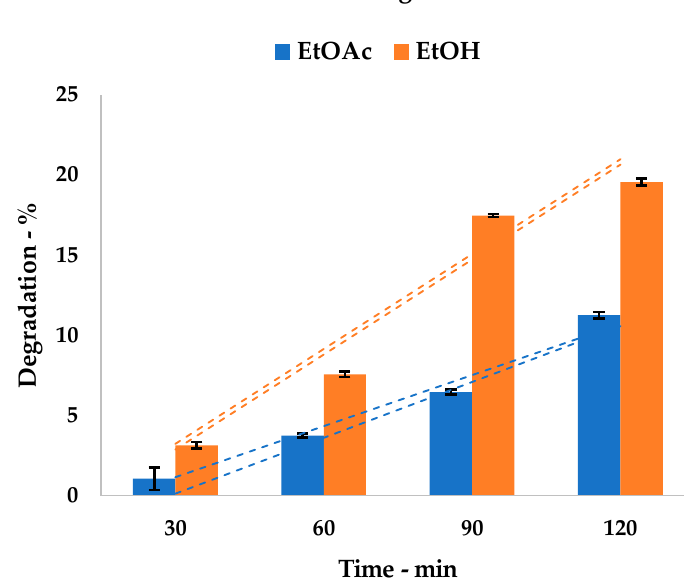
Figure 6. Curcumin extract degradation trend; A: ethanol; B: ethyl acetate; dashed lines represent upper and lower SD envelopes.